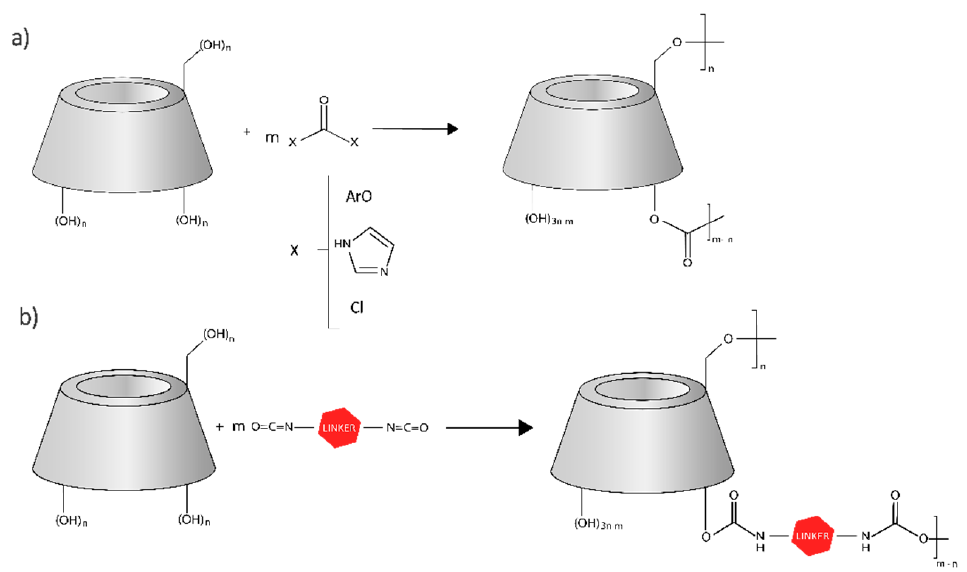
Figure 1. Schematic synthesis of ( a ) CD-based polycarbonate NSs and ( b ) CD-based polyurethane NSs (obtained from [24], published under Creative Commons license).